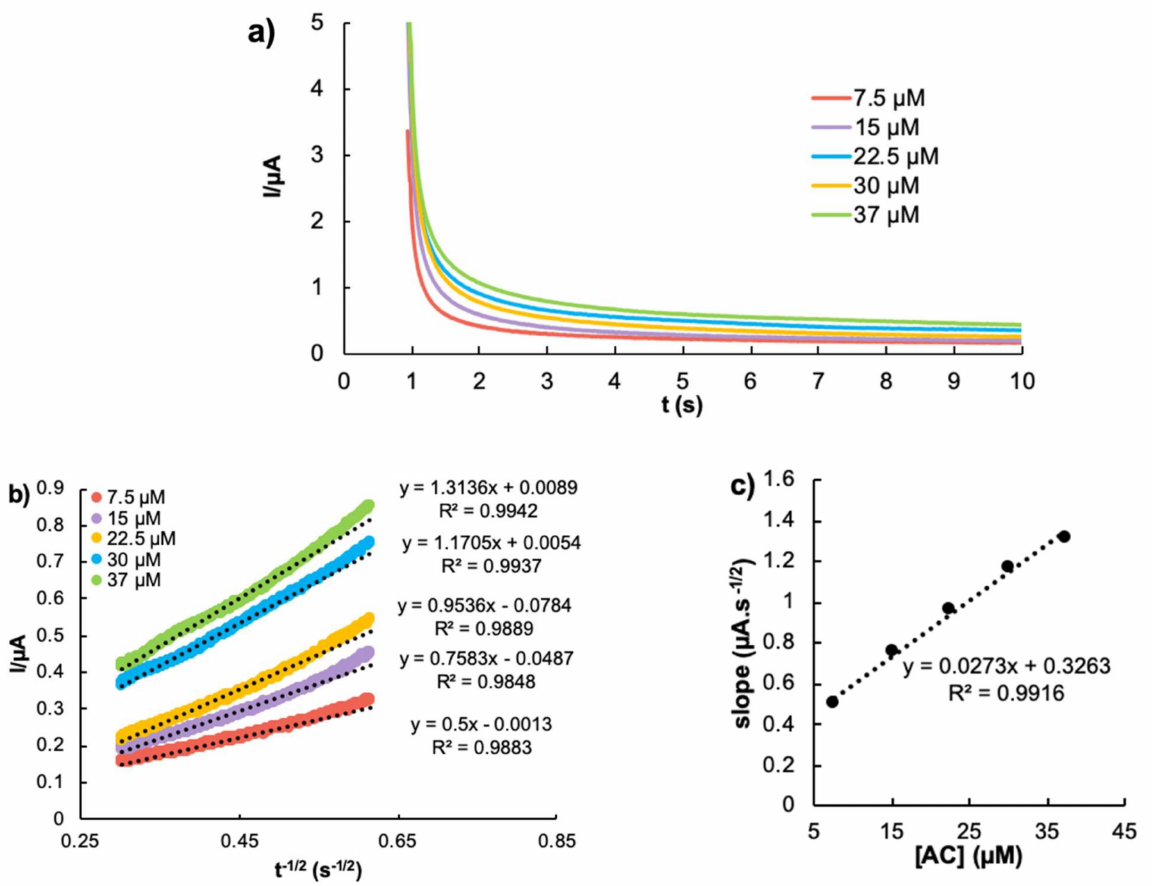
Figure 8. ( a ) Chronoamperograms of tPANI-Au@Pt-MWCNT-GCE in the presence of increasing concentrations of AC; 7.5 µ M (red), 15 µ M (purple), 22.5 µ M (blue), 30 µ M (yellow), and 37 µ M (green) in 0.5 M PBS (pH 3.0), ( b ) the t − 1/2 vs. I pa plots, and ( c ) is the slope obtained from ( b ) plotted against the concentration of